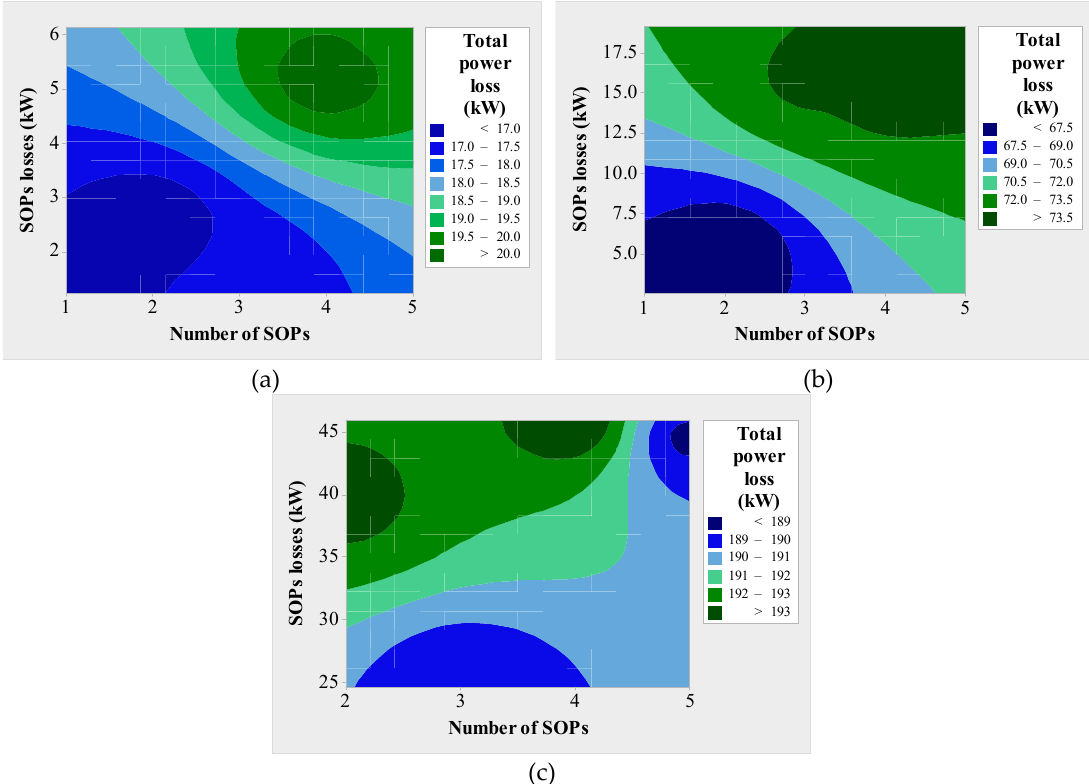
Figure 5. Contour plots of total power loss versus SOPs losses and N SOP : ( a ) light loading, ( b ) normal loading, and ( c ) heavy loading.